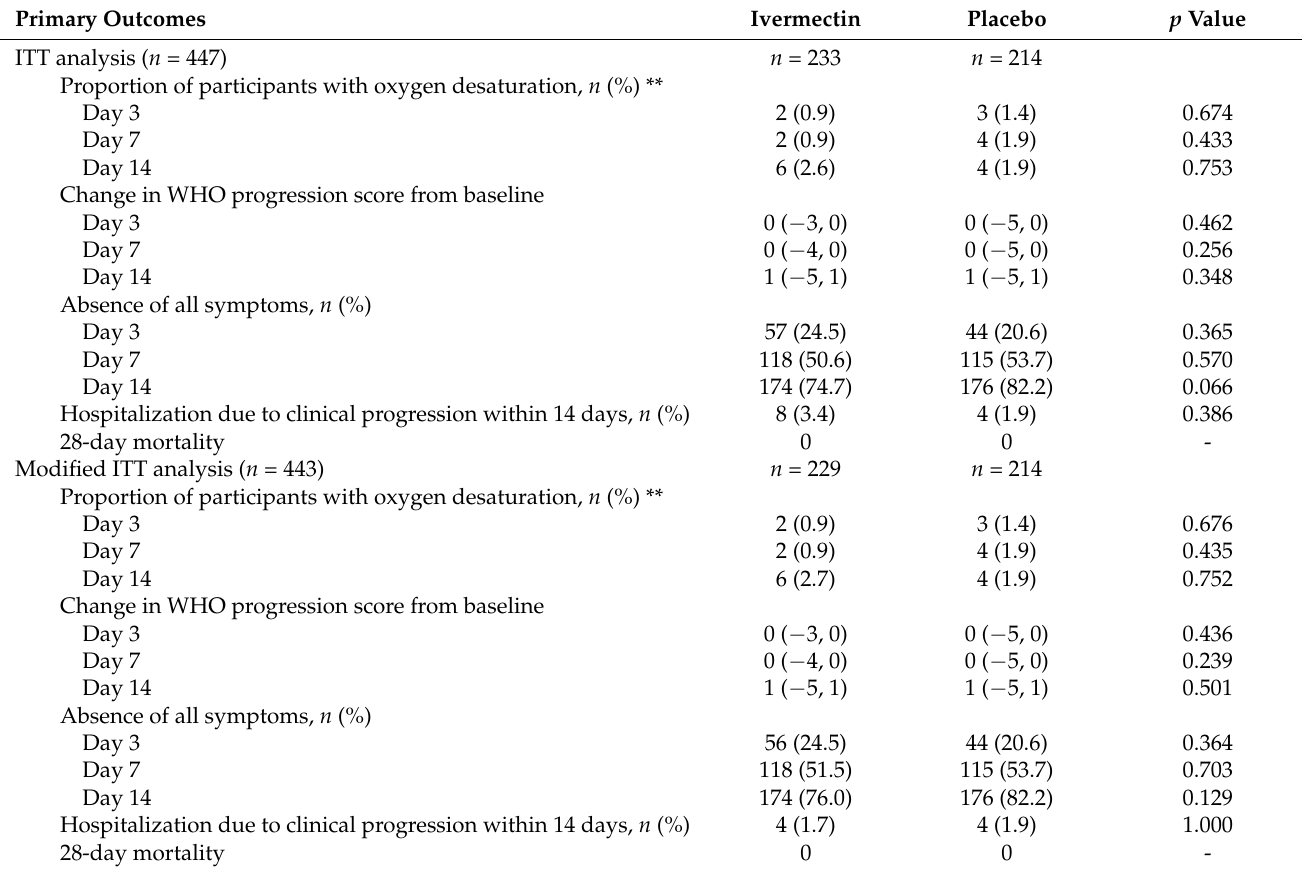
Table 4. Primary outcomes of the ivermectin treatment study classified by ITT and mITT